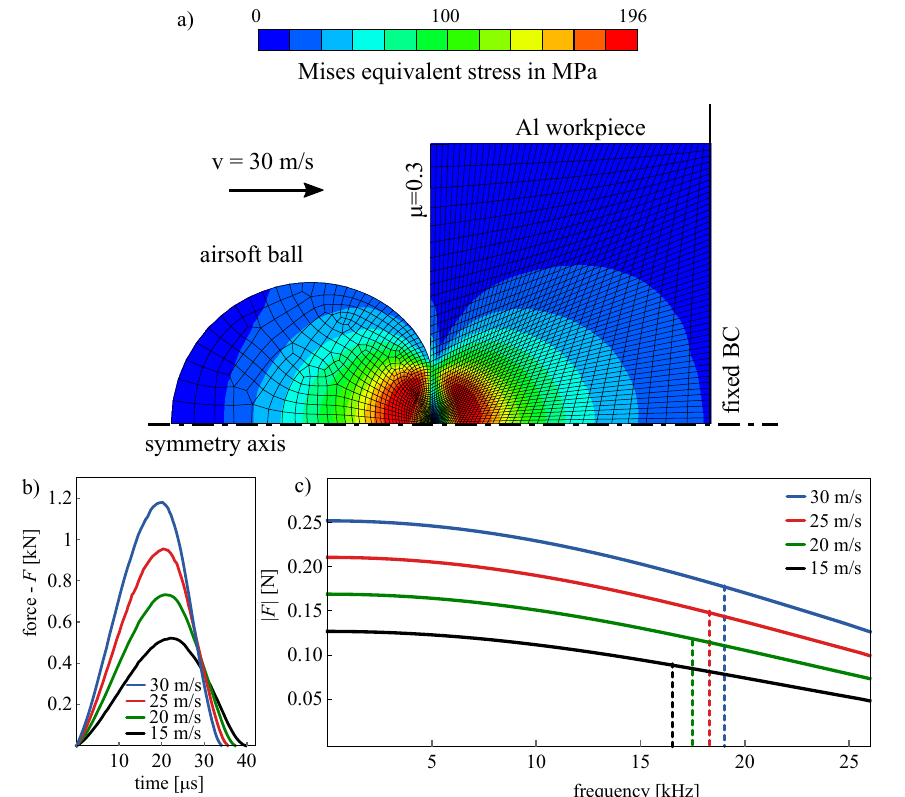
Figure 10. ( a ) The applied FE model with maximal deformation and stresses for v = 30 m/s, ( b ) the impact force characteristics and ( c ) the impact force spectrum and the limit corresponding to − 3 dB for v = 15, 20, 25, 30